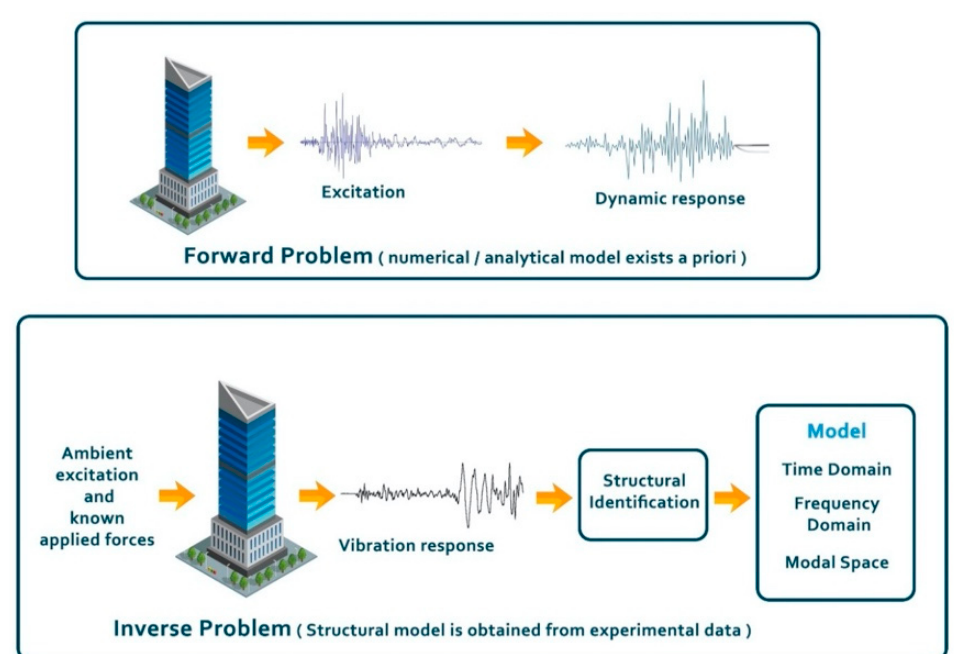
Figure 5. Dynamic response of a multi-story building using SHM.